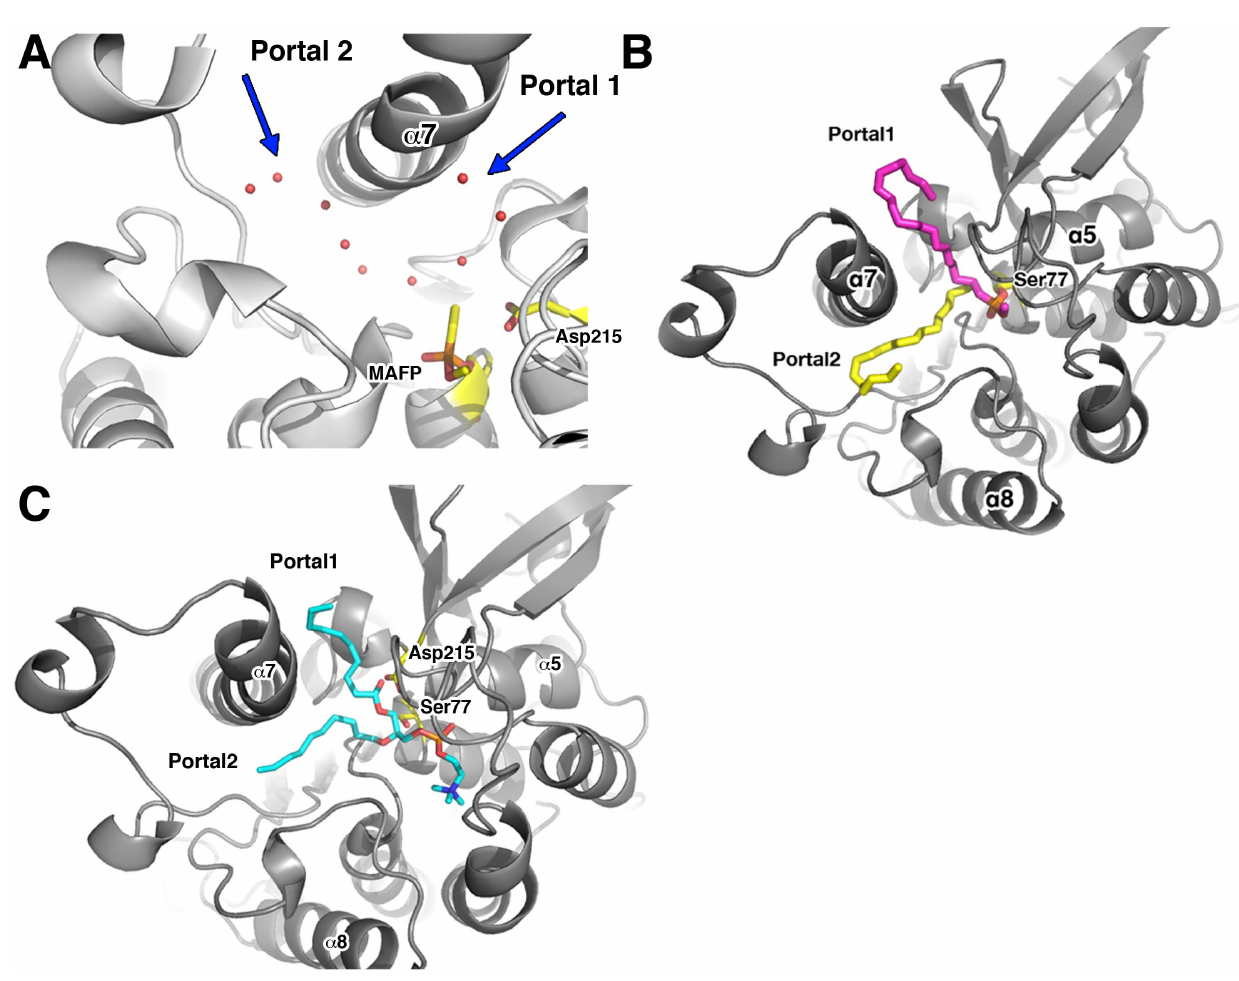
Figure 5. Substrate entry and exit points in Pat17. (A) Pat17 in complex with MAFP (with crystallographic water molecules shown as red spheres) depicting the trail of water molecules leading from the active site chamber through portals 1 and 2. (B) Model depicting the non-aged MAFP adduct with its arachidonic acid chain modeled as going through portal1 (with carbons colored magenta) or portal2 (with carbons colored yellow). (C) Model showing the phospholipid POPC (PDB ligand ID POV; depicted with carbons colored cyan) accommodated within the active site of pat17 with the lipid side-chains modeled within both, portal1 and portal2. The active site Ser77 and Asp215 residues as well as the MAFP and POPC moieties are rendered as sticks with the following color scheme: yellow/magenta/cyan = carbon, blue = nitrogen and red = oxygen. doi:10.1371/journal.pone.0108245.g005 PLOS ONE |